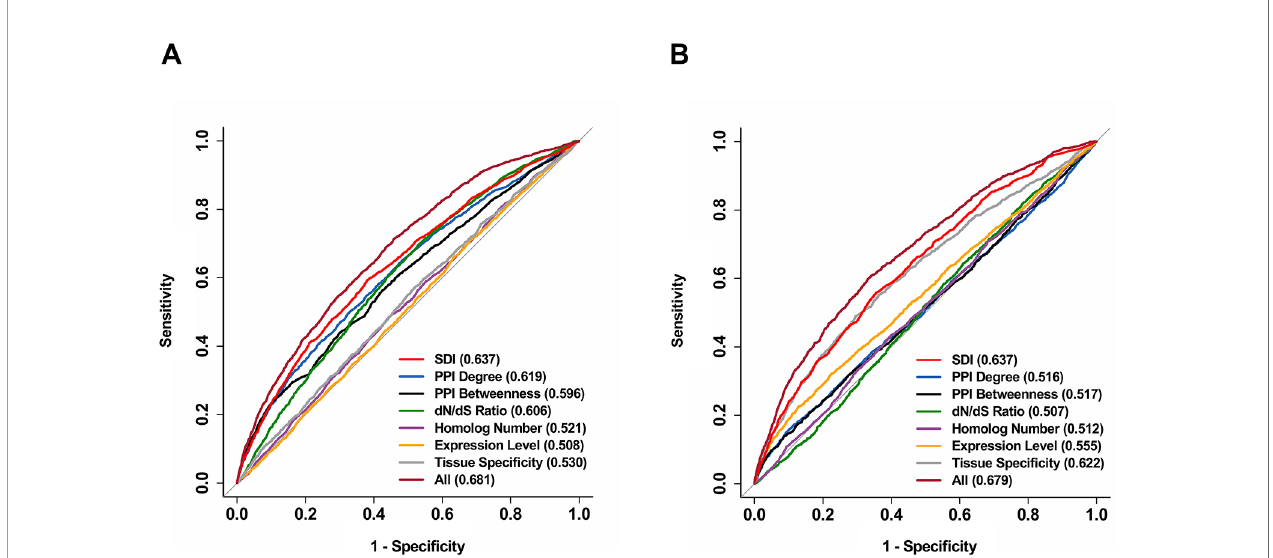
FIGURE 4 | Further validation for the performance of SDI in predicting human essential genes and drug targets. The ROC curves show the results from 10-fold cross-validation of the logistic regression models in predicting human essential genes (A) and drug targets (B) . All features were used in separate regression models, and a model including all available features was also provided for both essential genes and drug targets. The ROC curves were performed on 11,355 genes. The AUC scores are presented in the brackets. ROC, receiver operating characteristic; AUC, Area Under Curve.